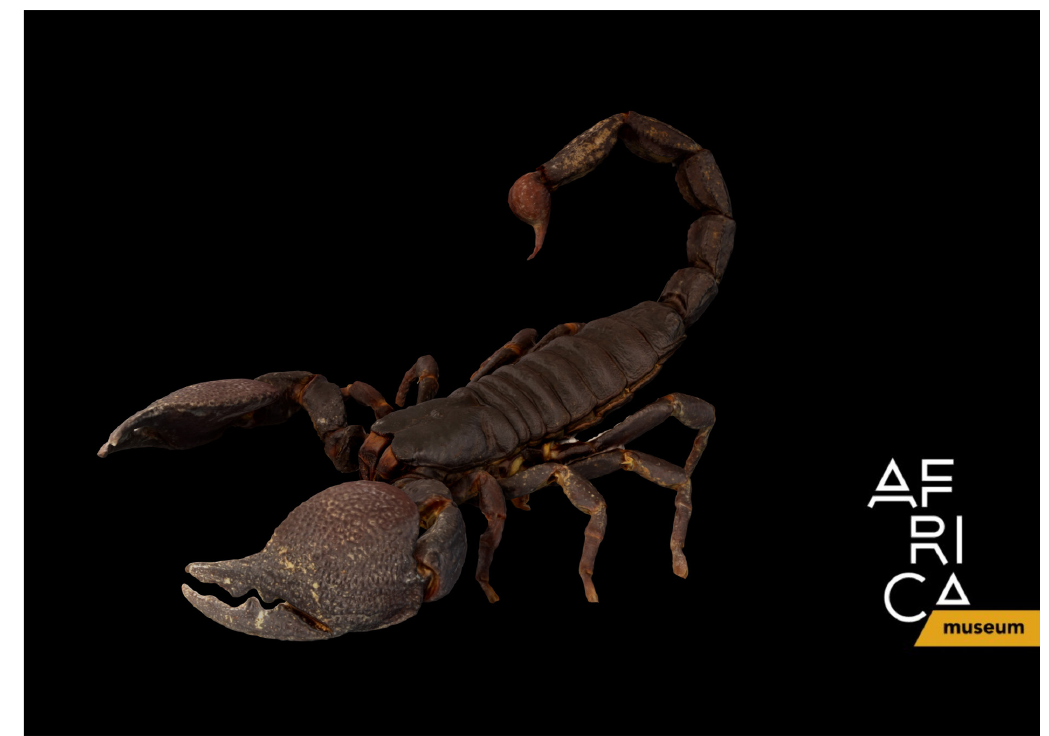
Fig. 3.8. Example of photogrammetry model of Pandinus imperator